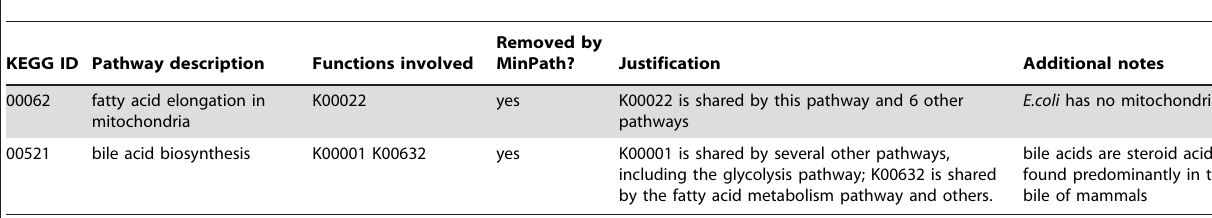
Table 2. Selected spurious pathways of the E. coli genome (collected in KEGG) eliminated by MinPath.